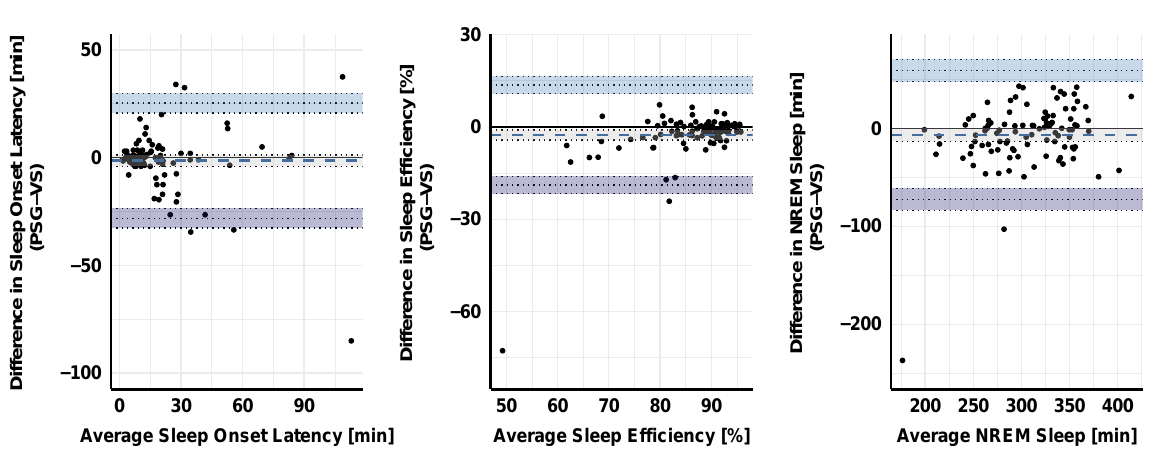
Figure 4. Bland–Altman difference plots between the PSG-based sleep variables for ( A ) H10 (upper row) and ( B ) VS sensor (lower row) on sleep onset latency, sleep efficiency, and NREM (light + deep) sleep. The dashed lines represent the mean difference (i.e., bias) between the two measurements. The dotted line with light and dark blue shading marks the 95 % CI limit of the mean difference. The black solid line represents the point of equality (where the difference between the two devices is equal to 0).